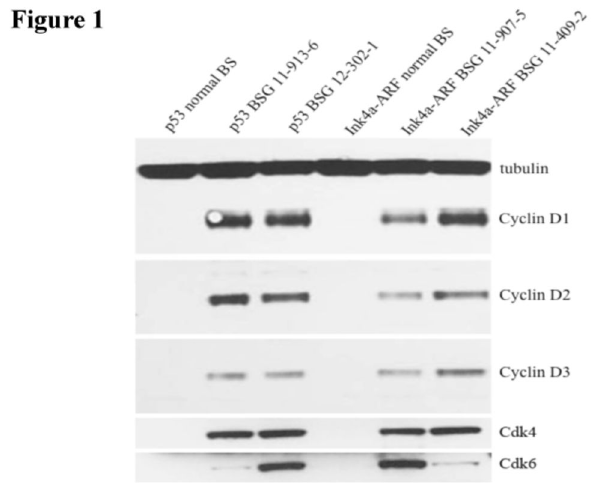
Figure 1. PDGF-B; Ink4a-ARF deficient and PDGF-B; p53 deficient BSG models overexpress all three D-type cyclins. Western blot for cyclins D1, D2, D3, CDK 4 and CDK 6. From left to right: lane 1 is normal brainstem from Ntv-a; p53 floxed mice, lanes 2 and 3 are two PDGF-B; p53 deficient BSGs, lane 4 is normal brainstem from Ntv-a; Ink4a-ARF deficient mice, lanes 5 and 6 are two PDGF-B; Ink4-ARF deficient BSGs. doi: